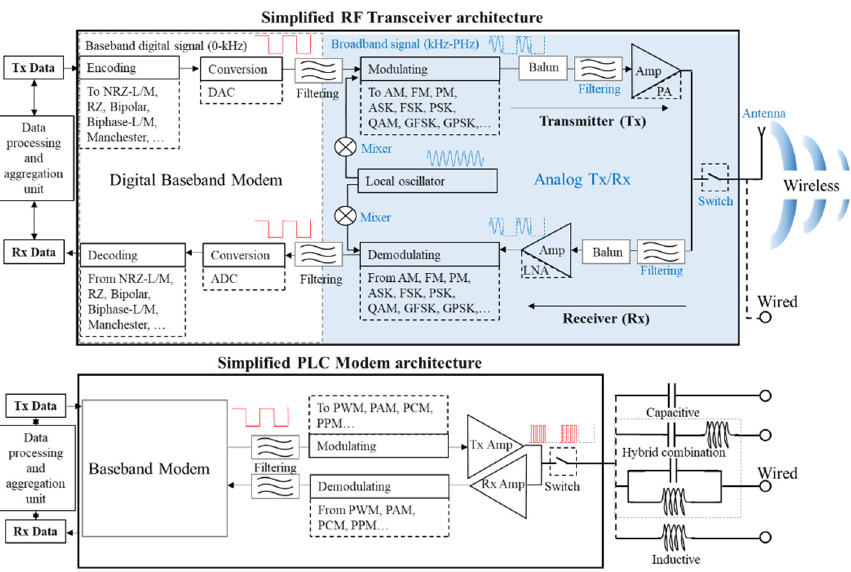
Figure 2. Internal architecture schematic representation for a generic RF transceiver ( top ) and a modem adapted for power-line communication (PLC) purposes ( bottom ). While the PLC modem can be connected to a network through inductive, capacitive, or hybrid wired coupling, the RF transceiver possesses an additional coupling via its antenna for wireless interconnections.